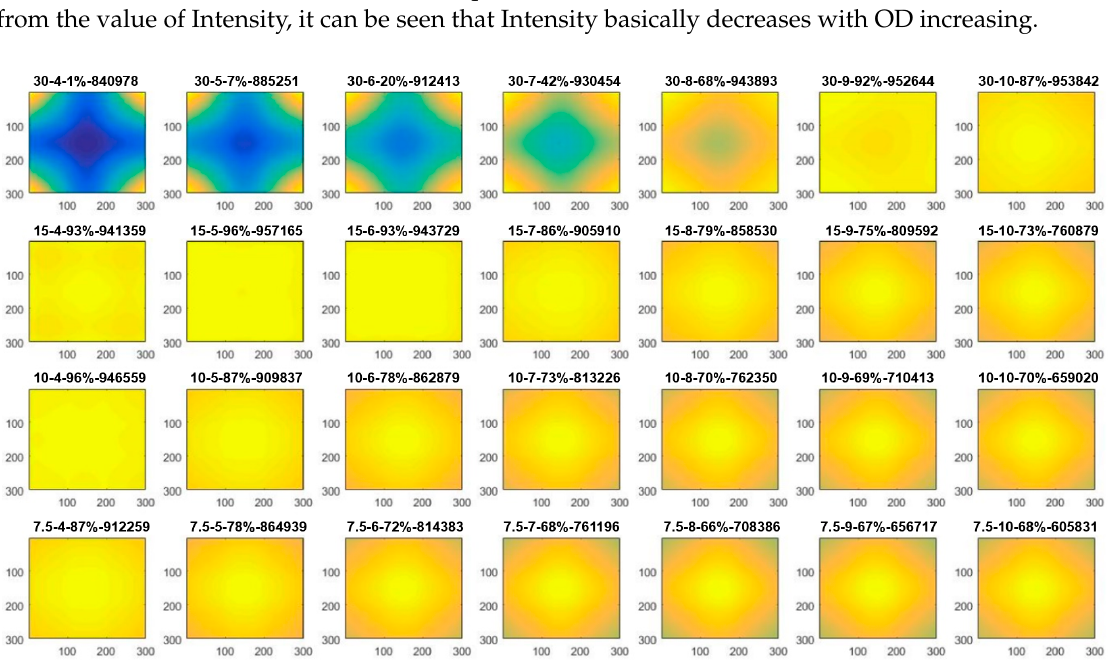
Figure 6. Array analysis of SMD.